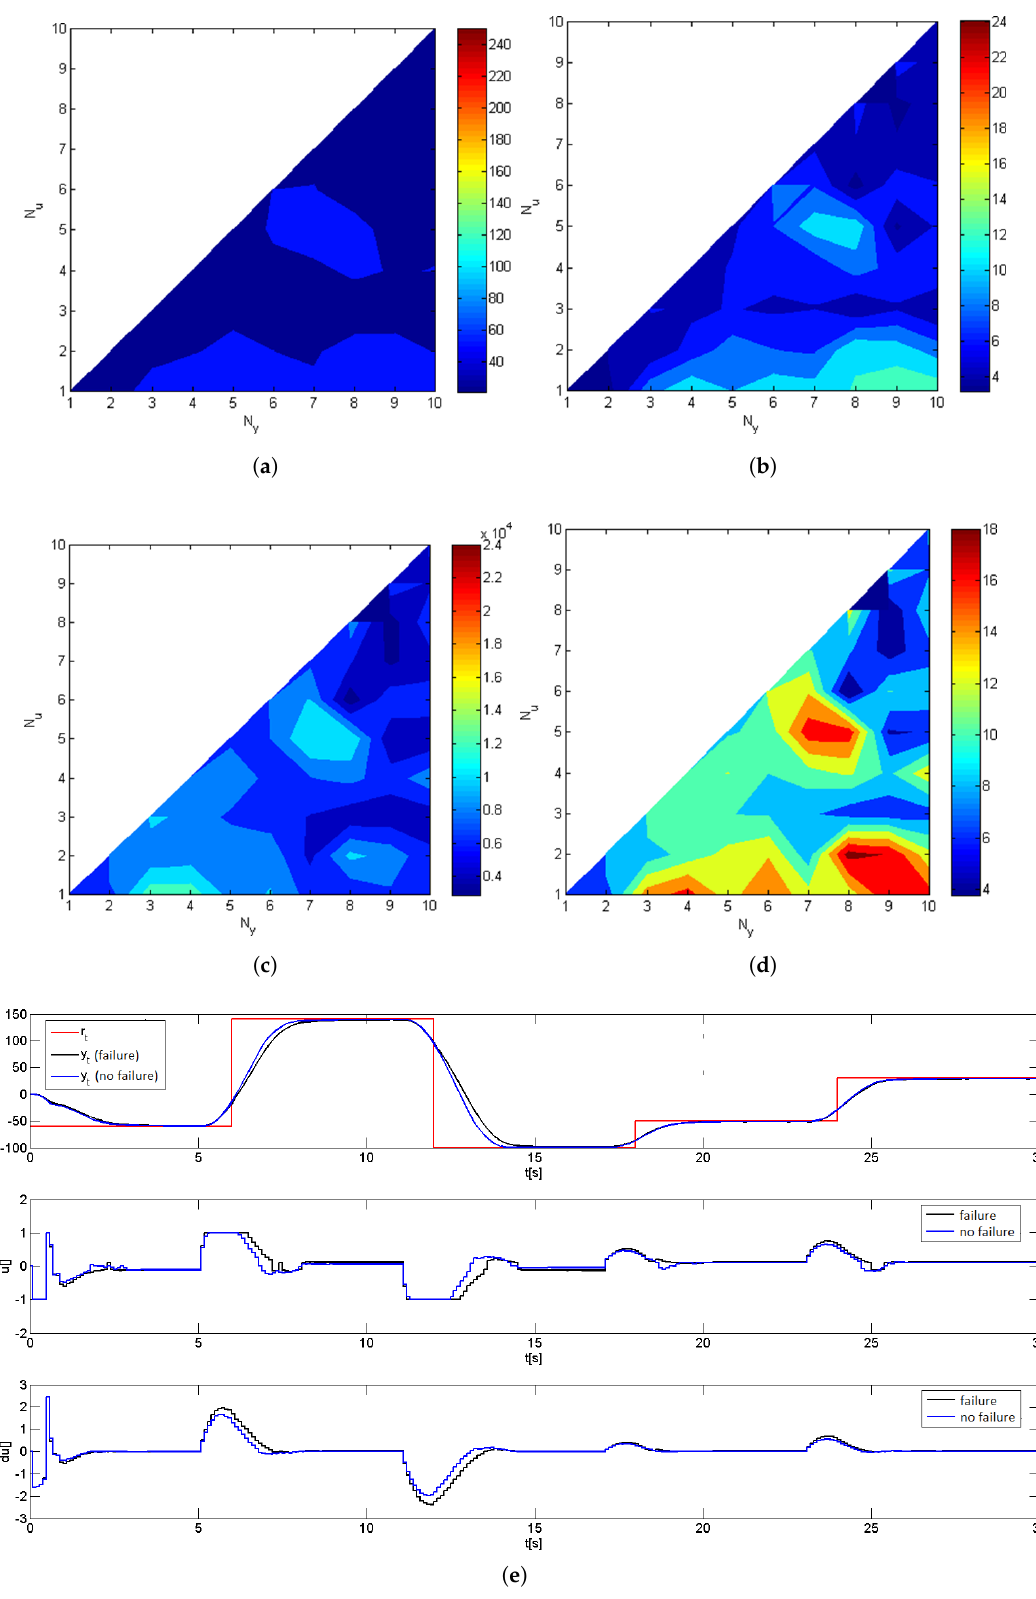
Figure 9. Experimental results concerning brake failure with q u = 3000, T S = 0.1 s. ( a ) Absolute IAE change; ( b ) Relative IAE change; ( c ) Absolute ISE change; ( d ) Relative ISE change; ( e ) Tracking performance with and without brake failure, N u = 5, N y =